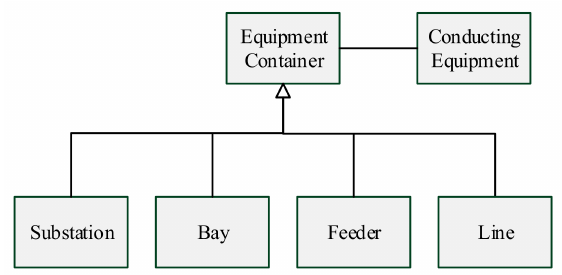
Figure 2. Feeder model.